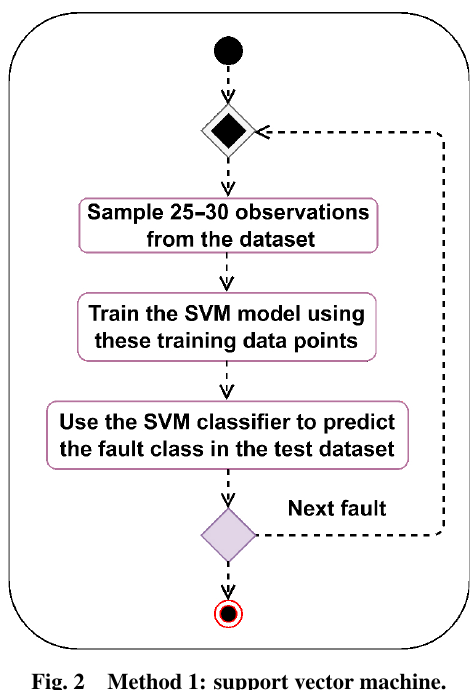
Fig. 2 Method 1: support vector